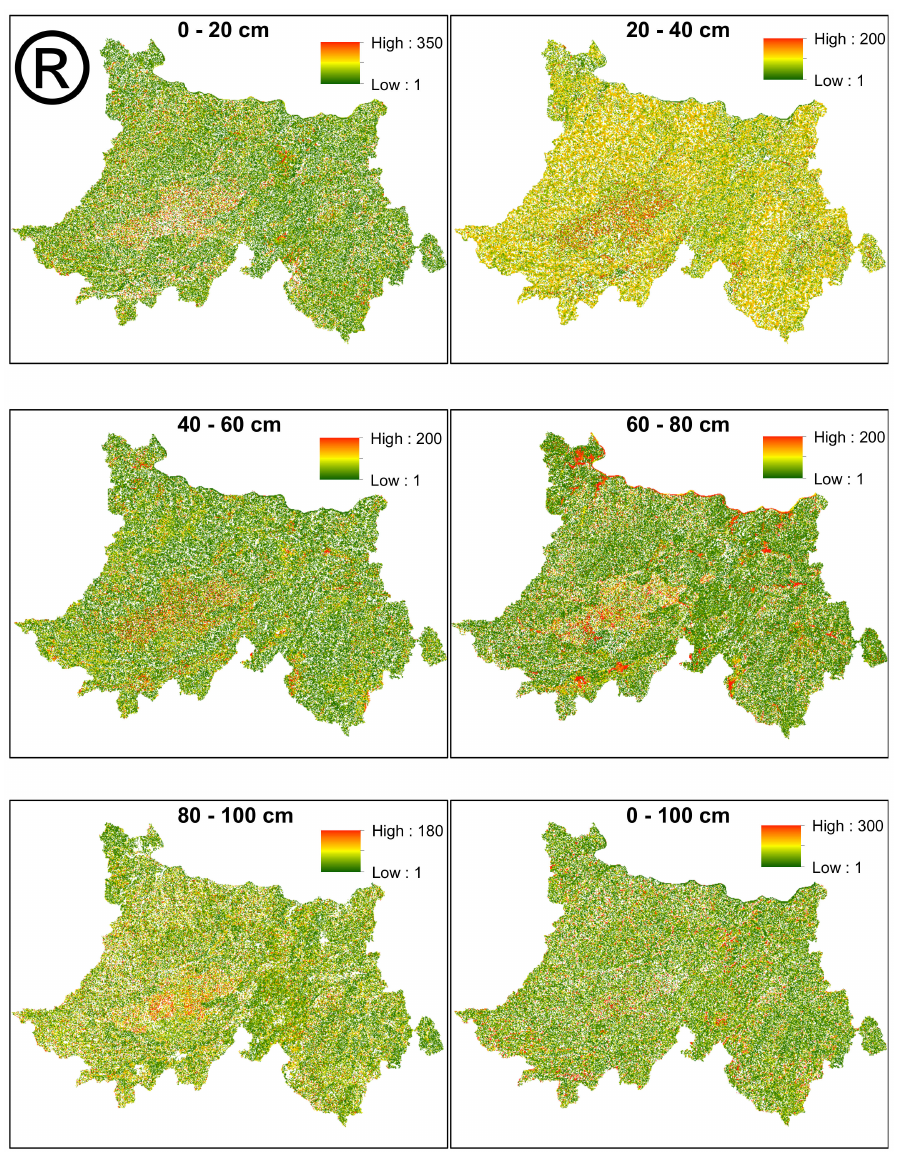
Figure 2. Prediction of soil Cd concentrations ( µ g mg − 1 ) for 5 soil depths with selected ANN